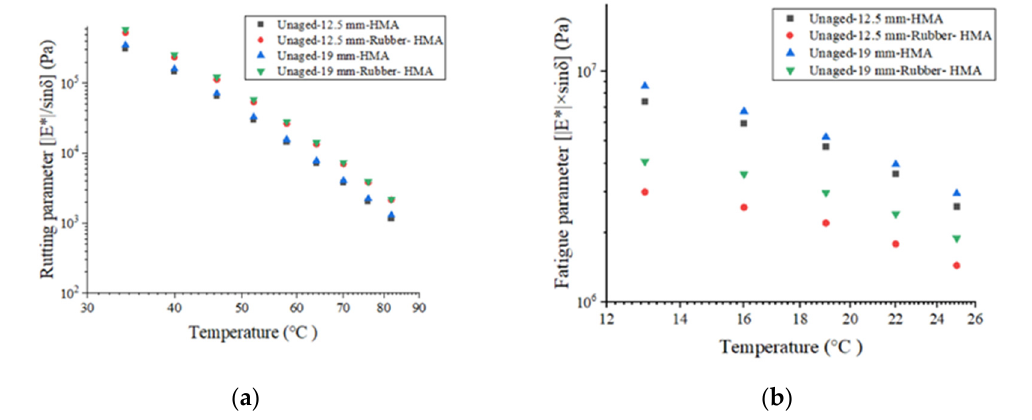
Figure 7. The asphalt binder potential of anti-rutting and anti-fatigue. ( a ) The rutting parameter (|G*|/sin δ ) of asphalt binder at 10 rad/s; ( b ) the fatigue parameter (|G*|×sin δ ) of asphalt binder at 10 rad/s.